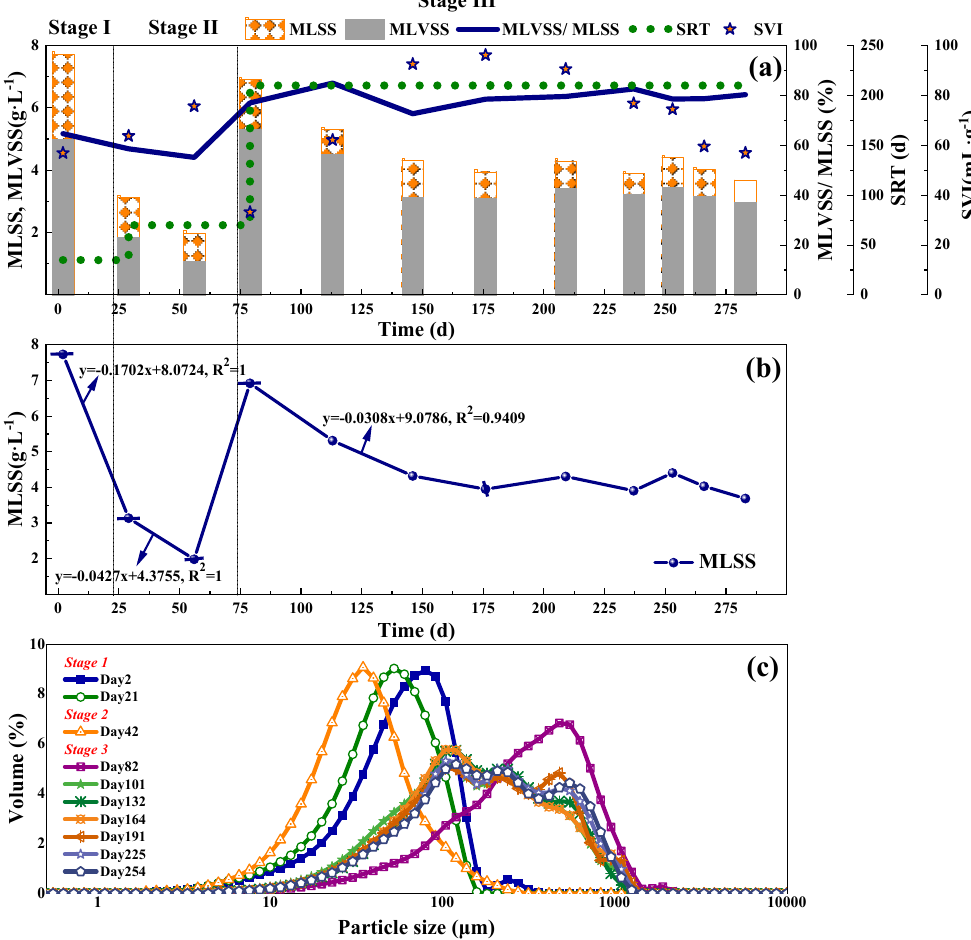
Figure 3. The sludge concentration, SRT, SVI ( a ), MLSS dynamic variations ( b ), and laser particle size distribution ( c ) of the SBR biomass.